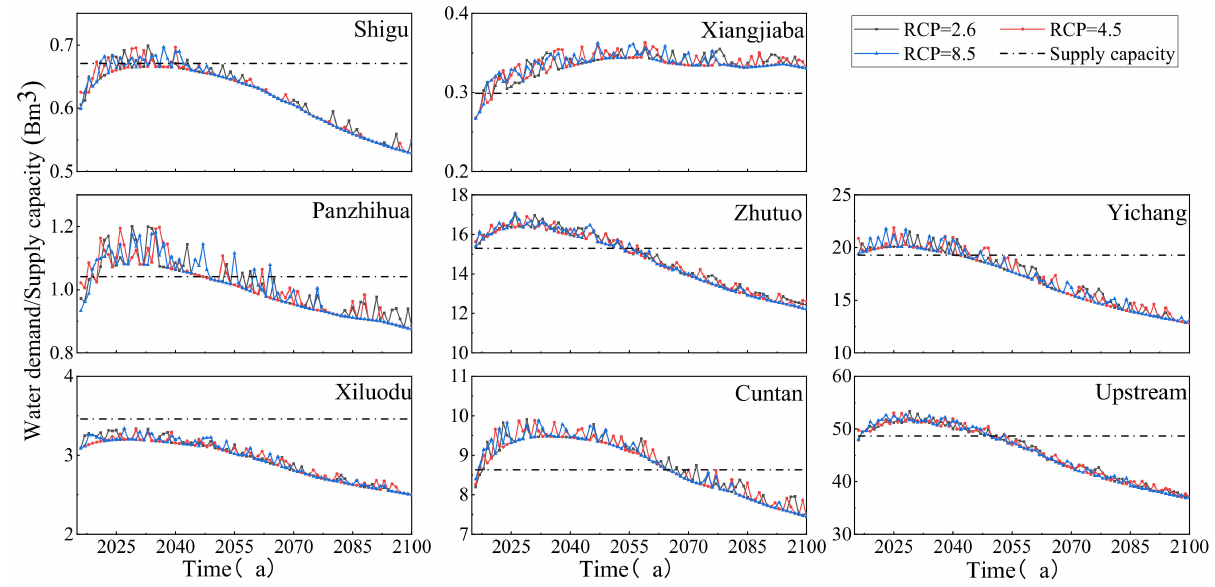
Figure 17. Contradiction evolution under supply capacity limitation in each